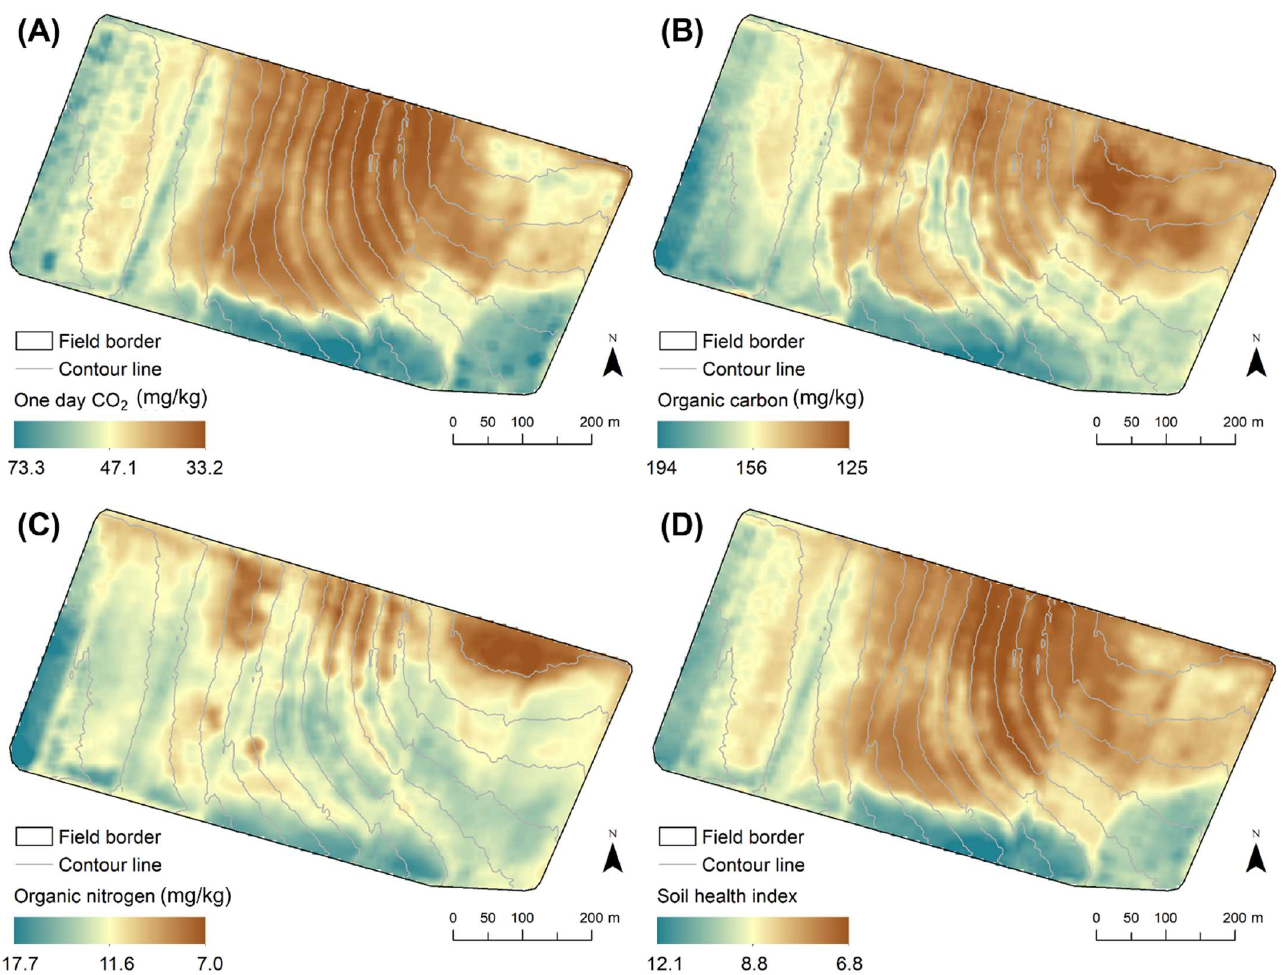
Figure 3. Predicted map of measured soil properties and soil health index, ( A ) one-day CO 2 ; ( B ) organic C; ( C ) organic N; and ( D ) soil health index in the study area.